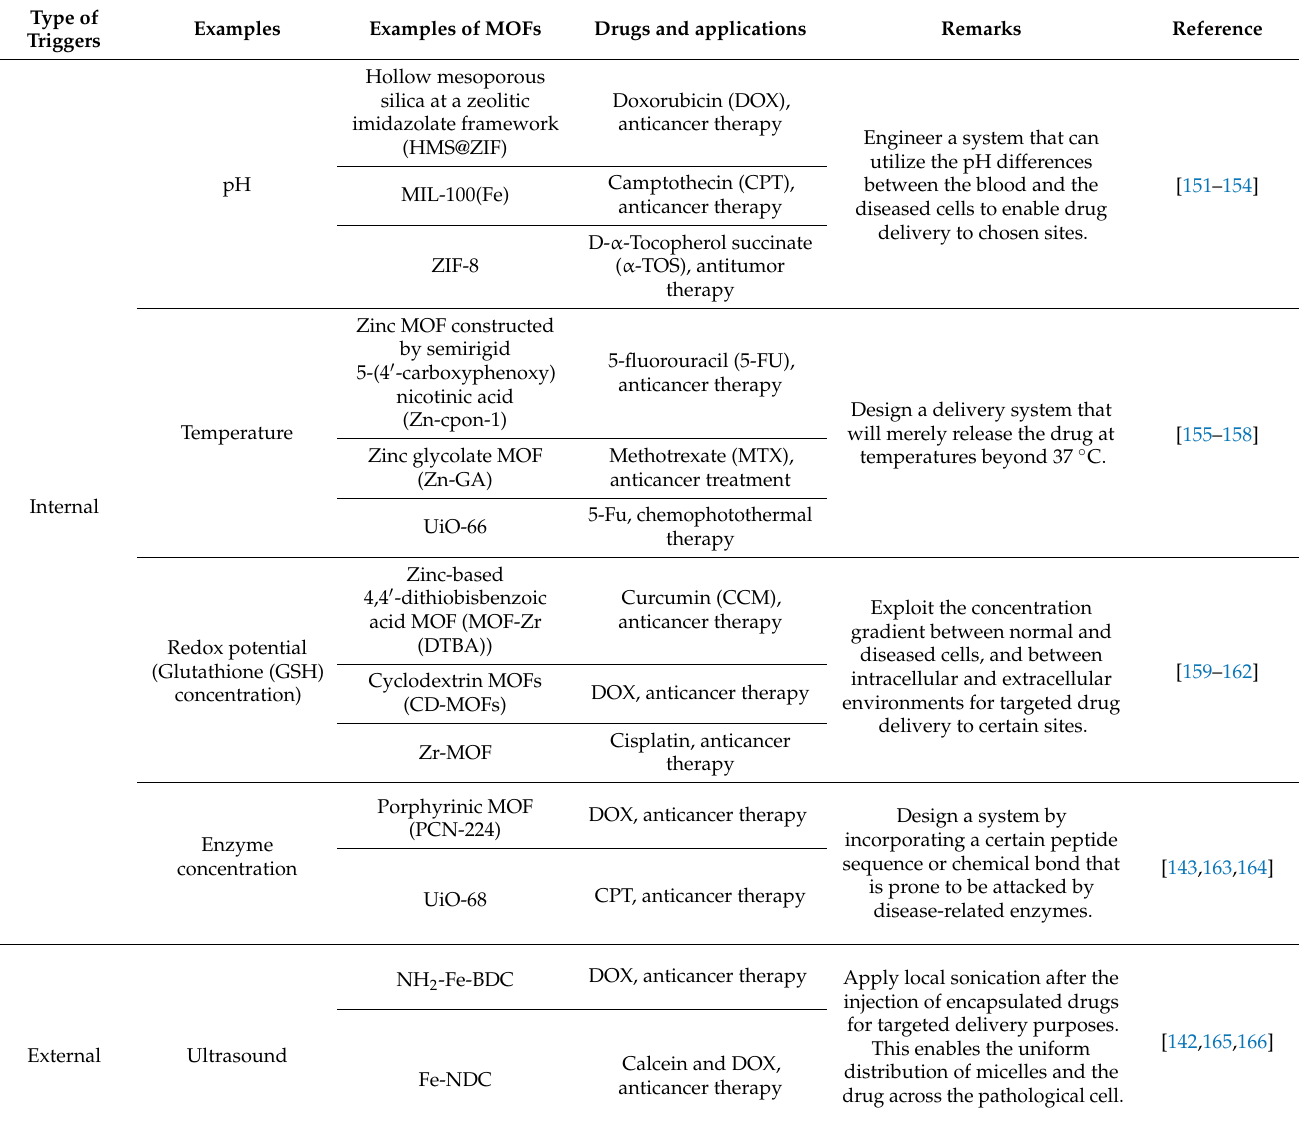
Table 3. Types of stimuli used in drug